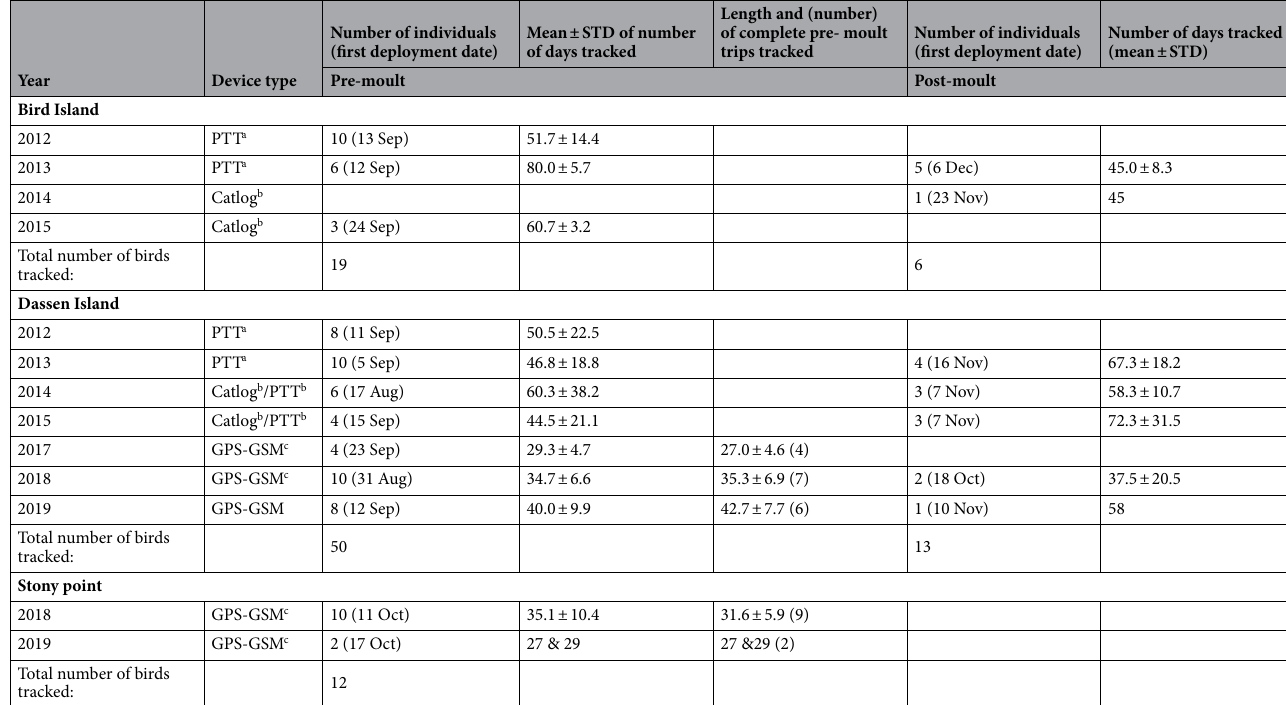
Table 1. The number of African penguins tracked for > 20 days from Dassen Island, Stony Point and Bird Island during their pre- and post-moult foraging trips between 2012 and 2019. a KiwiSat202,